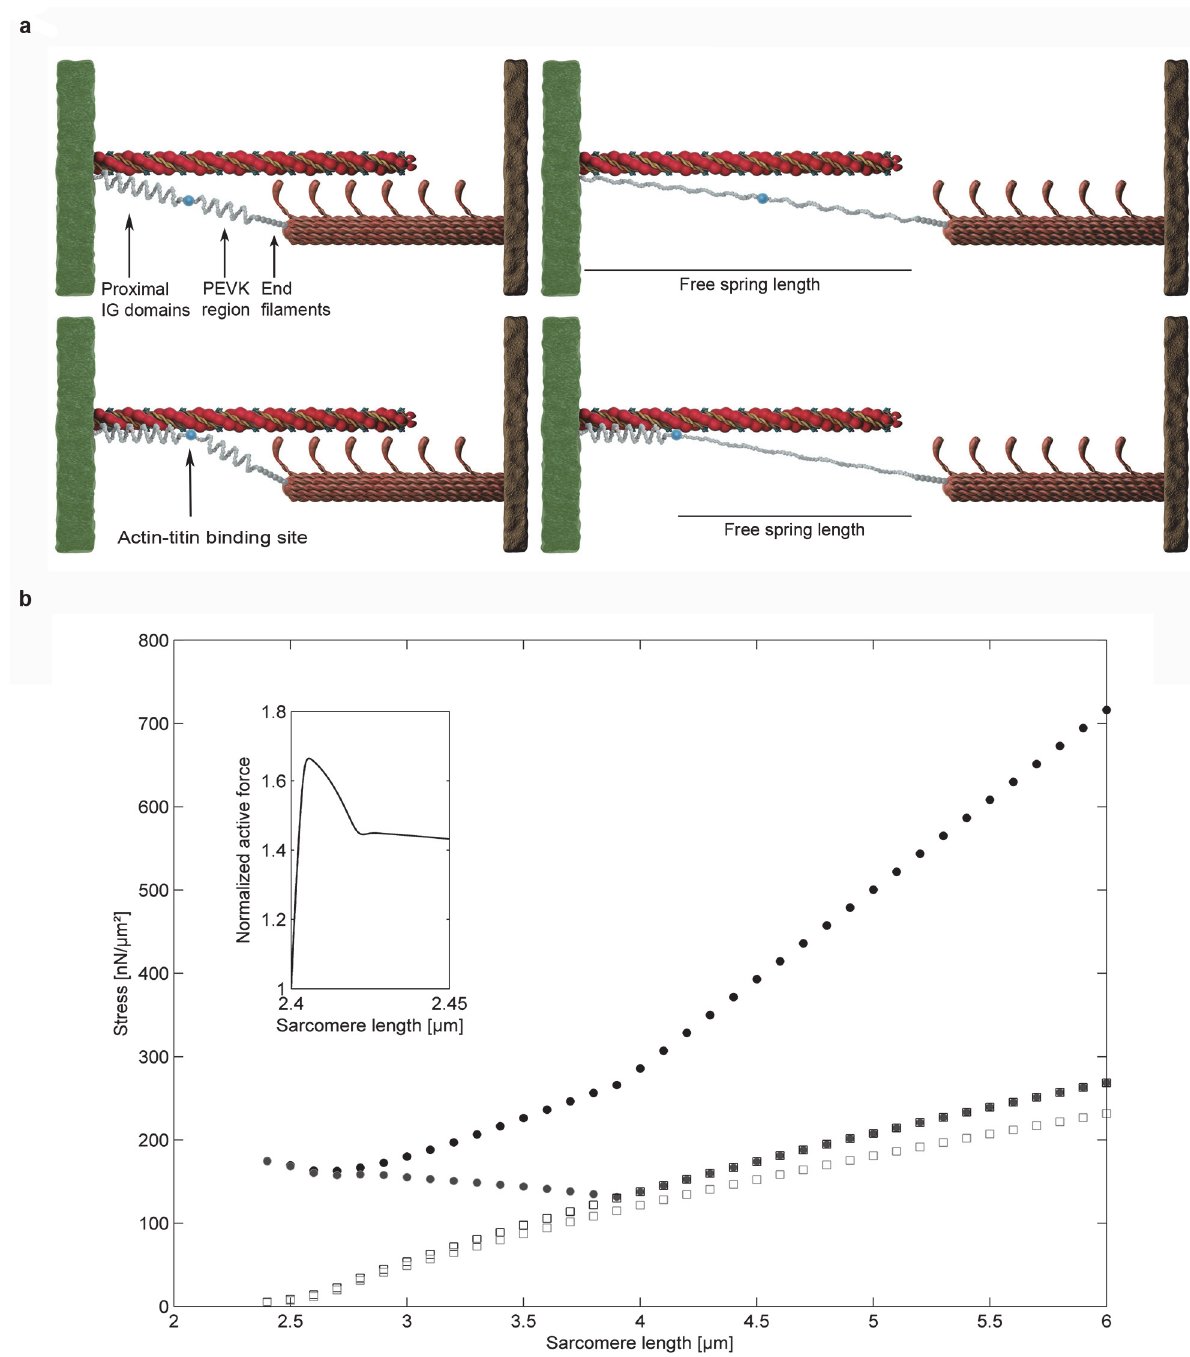
Fig 3. Simulation of stretching a single sarcomere beyond actin-myosin overlap. a , Sketch of an active stretch of a sarcomere without actin-titin interaction and with actin-titin interaction. b , The sarcomere is activated at a length of 2.4 μ m and stretched actively until the first protein structures start to break. The solid grey circles show the force-elongation relationship based on active force production by cross-bridges and passive force production based on increased titin stiffness and increased IG domain unfolding forces associated with high calcium concentrations, the open grey squares represent the purely passive forces, while the open black squares represent force production based on increased titin stiffness and increased IG domain unfolding forces but inhibited cross-bridge interaction. Finally, the solid black circles represent an active stretch condition involving actin-titin interactions. The small insert shows normalized active force and thereby the dynamic response of cross-bridges to the induced stretch at higher time resolution.